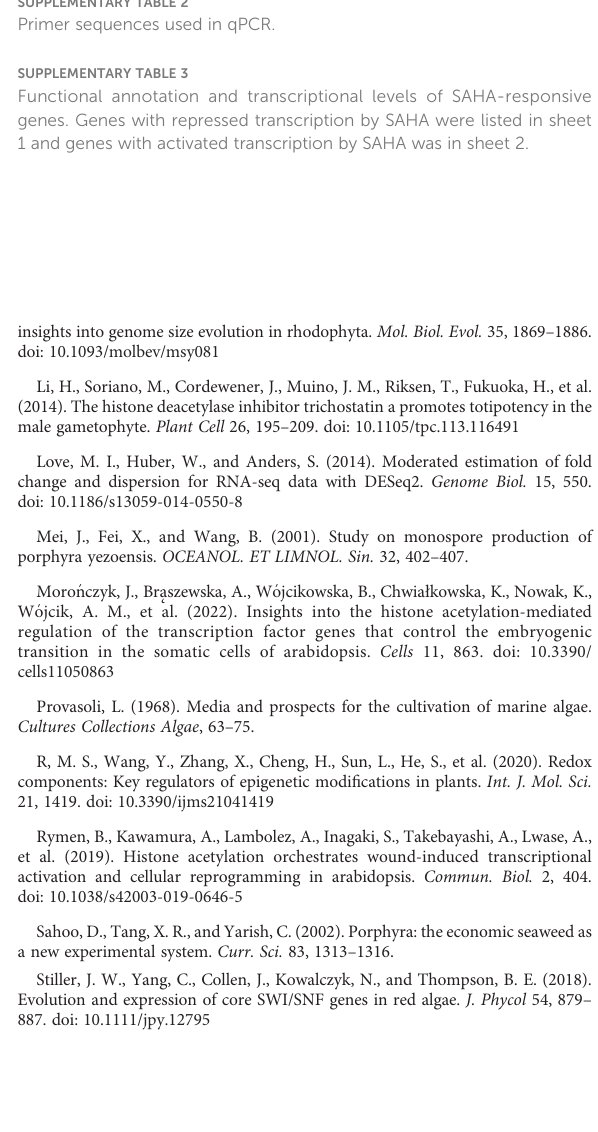
Primer sequences used in